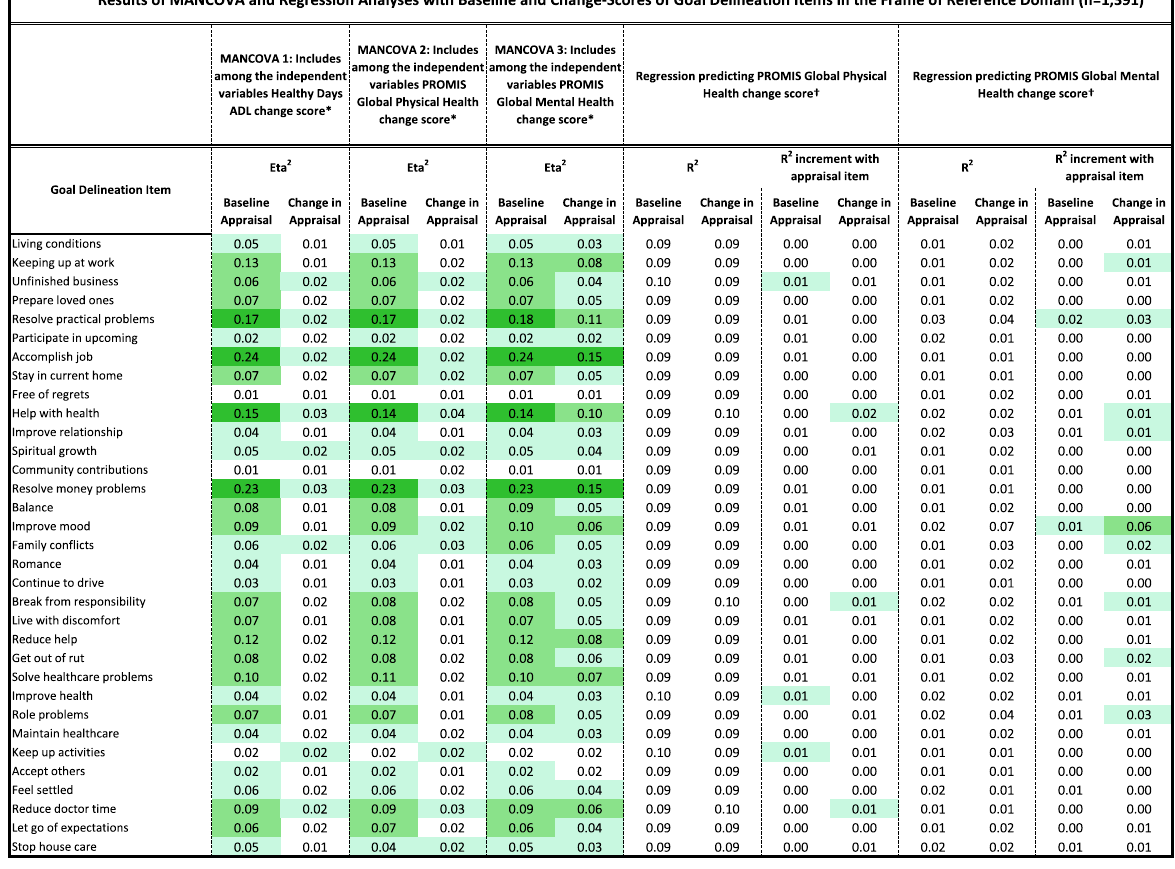
Table 3 Results of MANCOVA and Regression Analyses with Baseline and Change-Scores of Goal Delineation Items in the Frame of Reference Domain ( n =